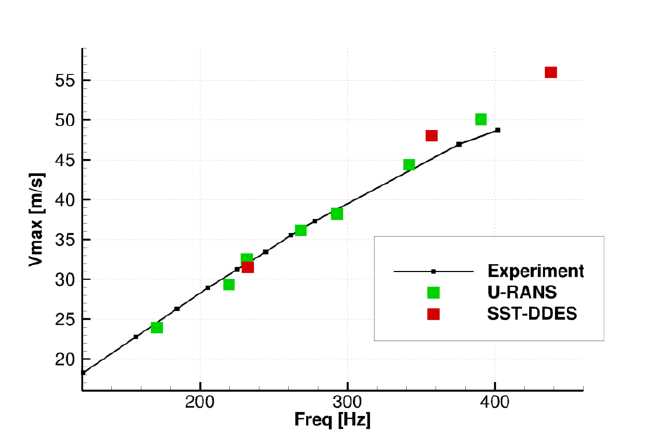
Figure 5. Comparison of the Computational Fluid Dynamics (CFD) results with the experimental data [21].